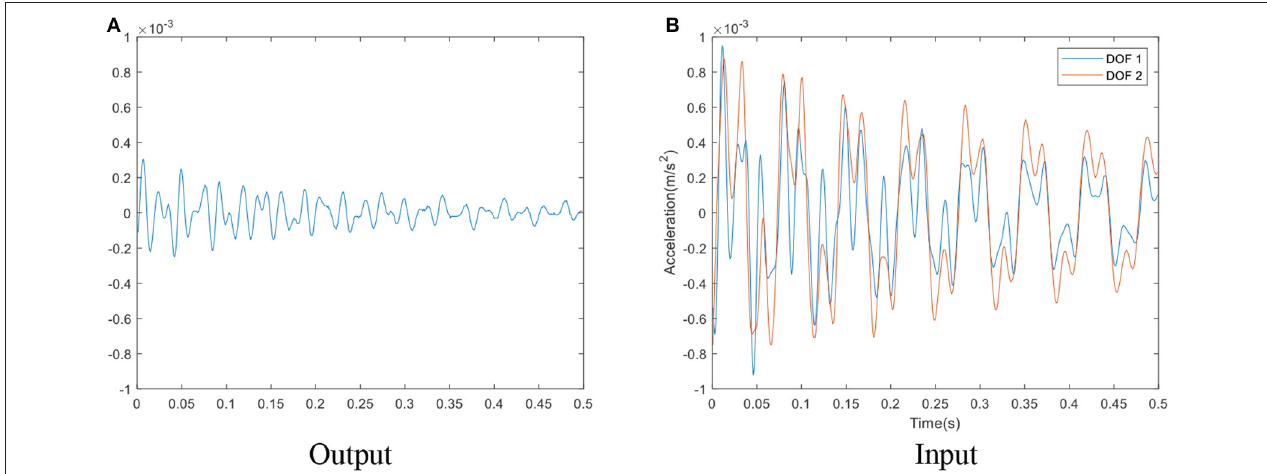
FIGURE 6 | Original accelerations of the first sensor cluster of healthy case of case study 1. (A) Output. (B) Input.